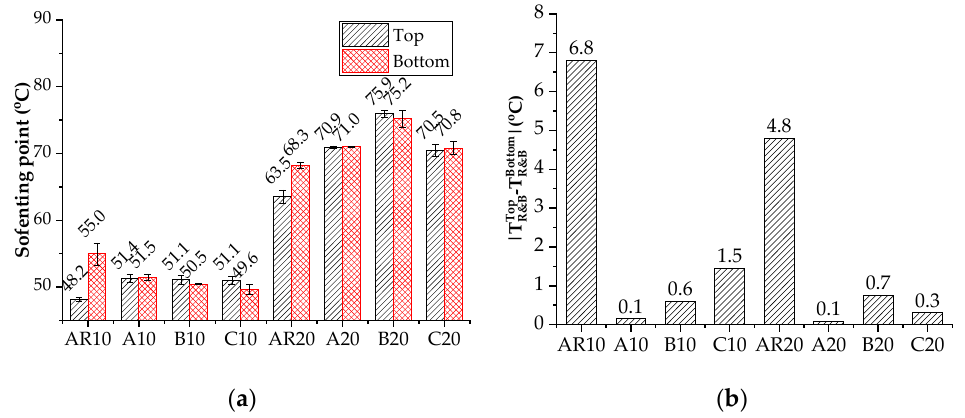
Figure 9. Softening point difference of ARs and ARNs after storage: ( a ) Softening points of top and bottom sections; ( b ) D-value between top and bottom sections.